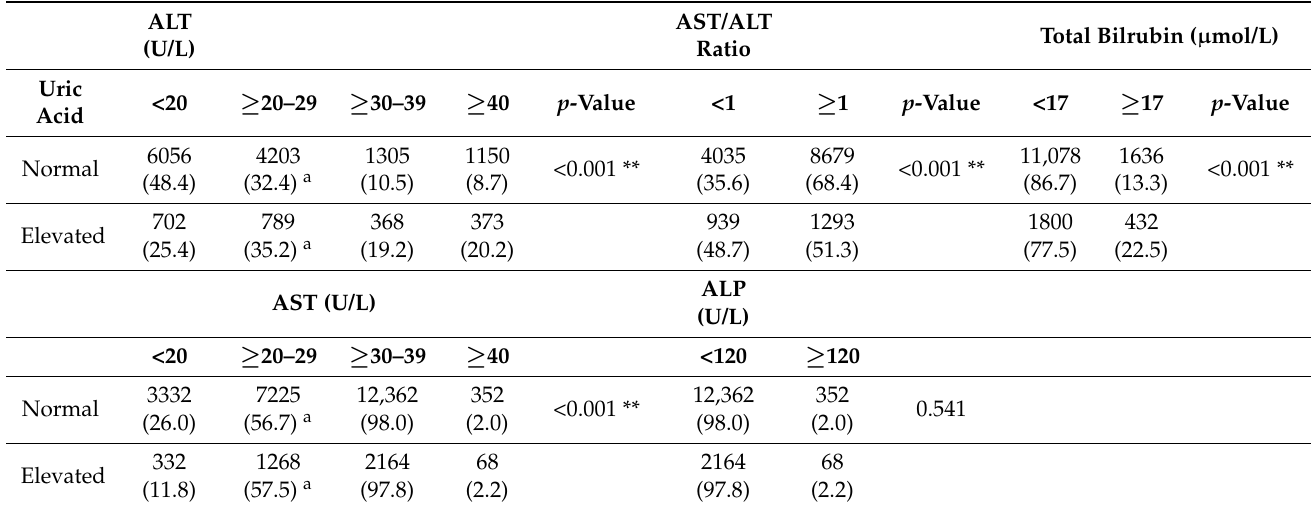
Table 2. Association between Hyperuricemia and Liver Enzymes.